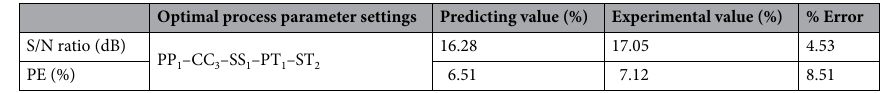
Table 7. Confirmatory results comparison at the optimal level.